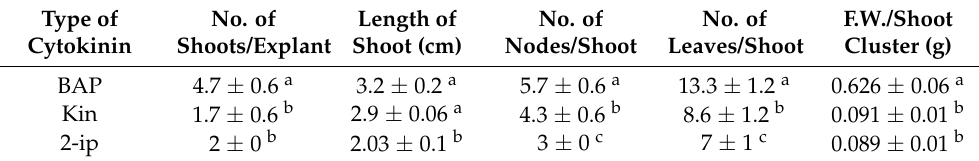
Table 5. Effect of 2 mg/L of different cytokinins in combination with 0.1 mg/L NAA in semisolid